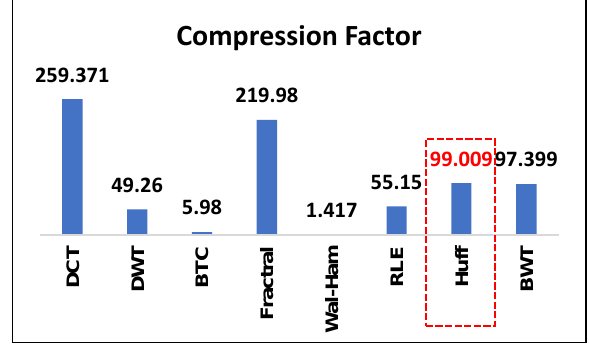
Figure 11. Performance on the basis of compression factor offered by different image compression algorithms